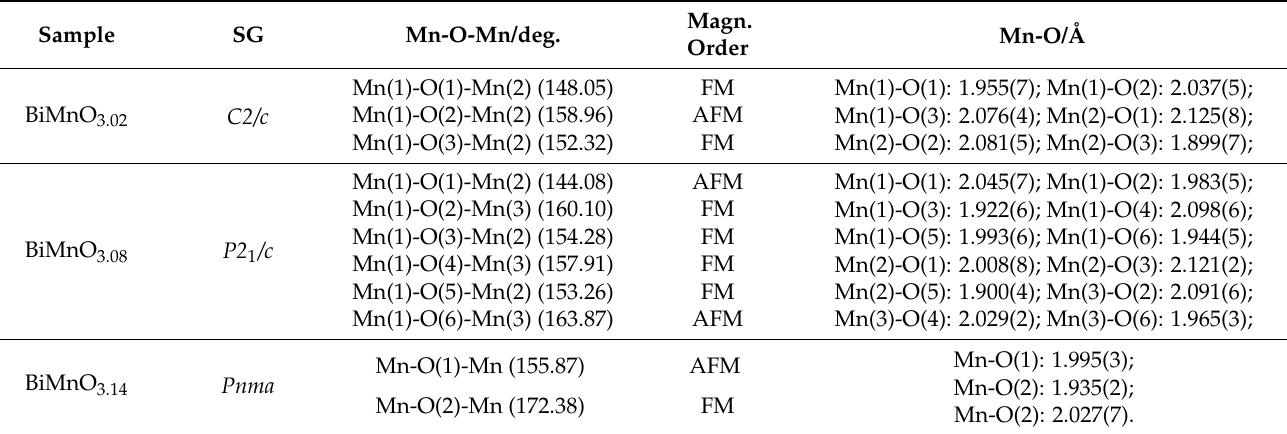
Figure 1. SPD pattern of the compound BiMnO 3.02 refined using the space group C2/c . Inset shows the reflections specific to the compounds BiMnO 3+ δ ( δ = 0.02, 0.08, 0.14). Images on the right show the temperature evolution of the selected SPD reflections of the compound BiMnO 3.02 . Table 1. Selected structural parameters of the BiMnO 3+ δ compounds refined based on the synchrotron and neutron diffraction